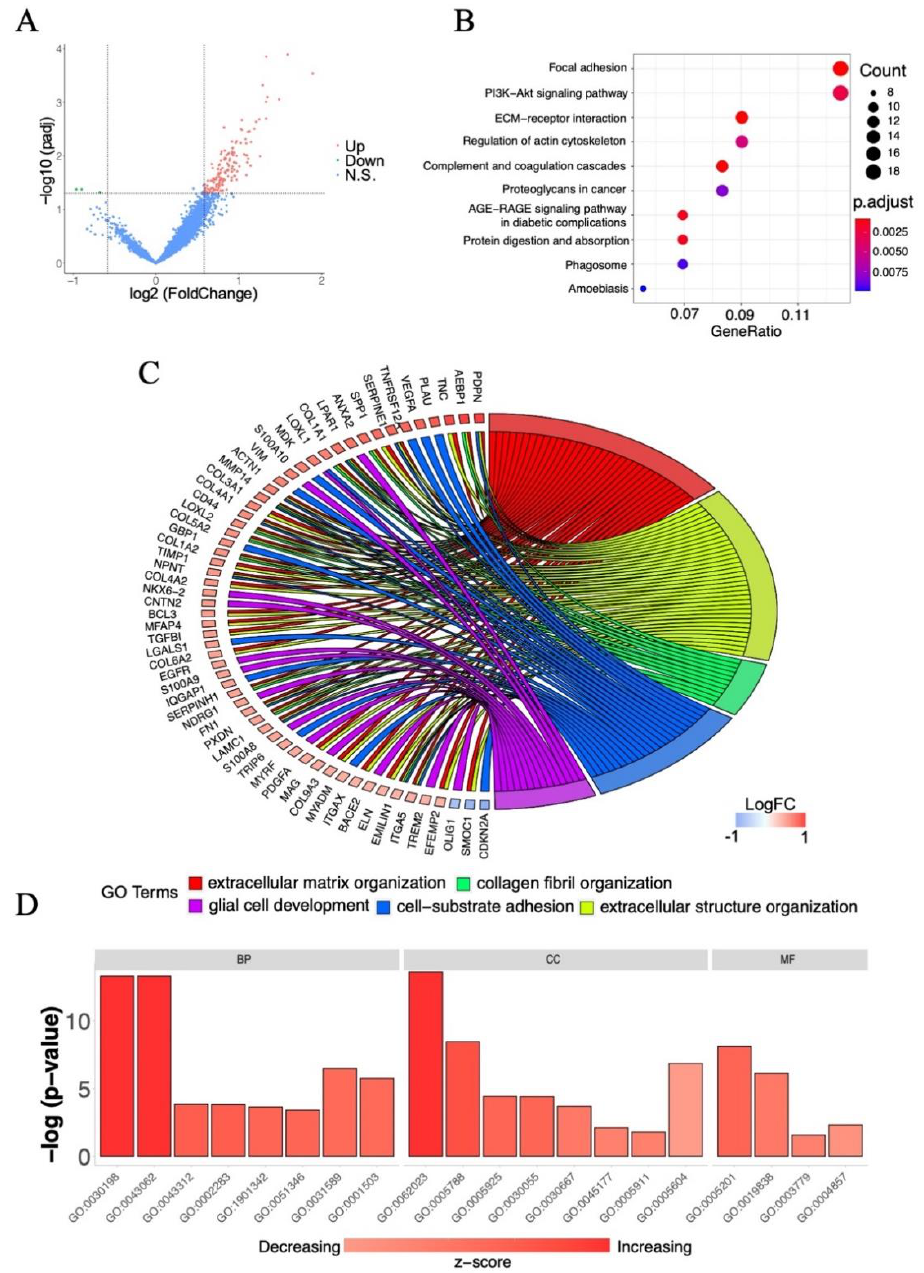
Figure 2. Analysis of the survival-associated genes from CGGA database. ( A ) Volcano plot of the distribution of gene expressions of high-survival group in comparison with low-survival group. Red dots represent upregulated genes (Up), green dots represent downregulated genes (Down), and blue dots represent no significant change genes (N.S.). p < 0.05 is considered statistically significant with the threshold of fold change >1.5 or fold change <0.6667 (i.e., |log2 fold change} >0.585). ( B ) Dot plot of top ten KEGG pathways of survival-associated genes. ( C ) Chord plot of GO terms for survival-associated genes. logFC indicates log2 fold change. ( D ) Bar plot of GO terms for survival-associated genes. The z-score was automatically computed with the Bioconductor package